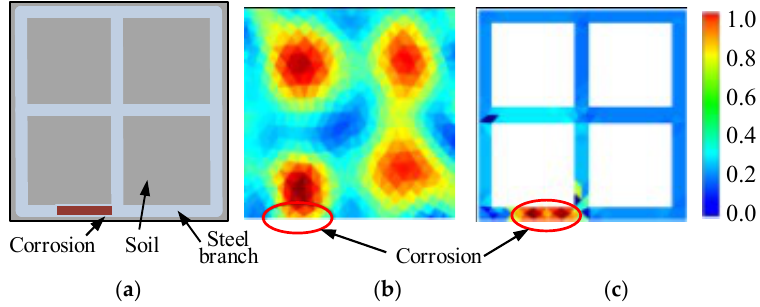
Figure 5. Imaging results with and without soil. ( a ) Imaging model; ( b ) With soil; ( c ) Without soil.